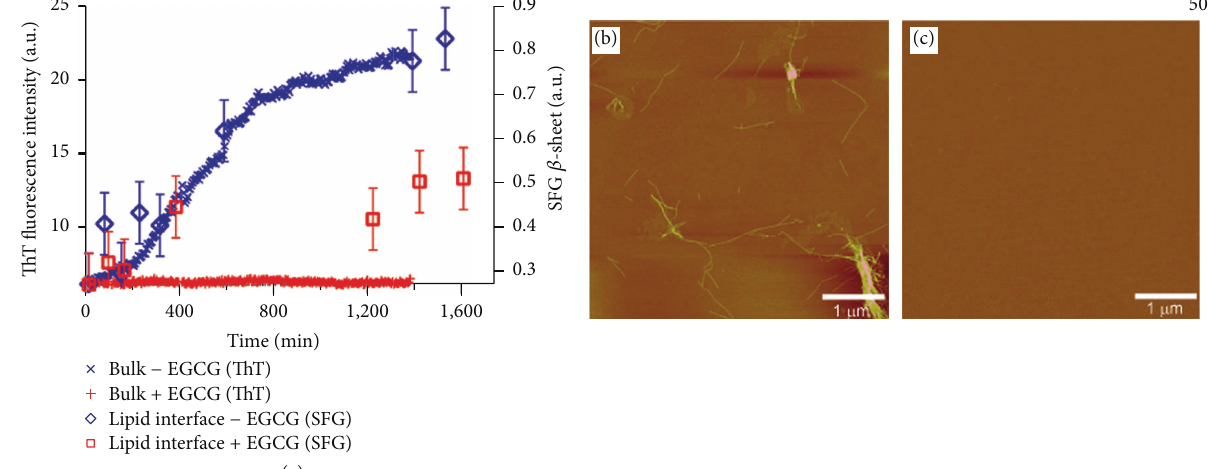
Figure 6: Bonn and coworkers compared the inhibitory effect of EGCG on hIAPP fibrillation in the bulk and at the phospholipid interface. (a) In the bulk, the formation of hIAPP amyloid fibrils was measured using a ThT fluorescence assay. The sigmoidal increase in fluorescence signal in the absence of EGCG ( × ) indicates the formation of hIAPP fibrils, and the low fluorescence signal in the presence of EGCG at a 1: 1 molar ratio (+) suggests the inhibition of fibril formation. At the phospholipid interface, in absence ( ⬦ ) and presence ( ◻ ) of EGCG, SFG spectra measure the formation of 𝛽 -sheets. (b) AFM also shows hIAPP fibrils formed in the absence of EGCG and (c) EGCG completely inhibits fibril formation of hIAPP. Adapted from [64] with permission. Copyright 2012 American Chemical Society.